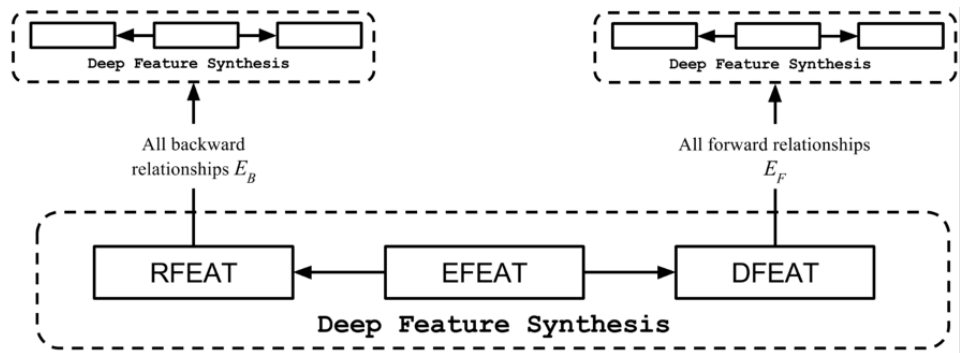
Figure 4. Deep Feature Synthesis [53].